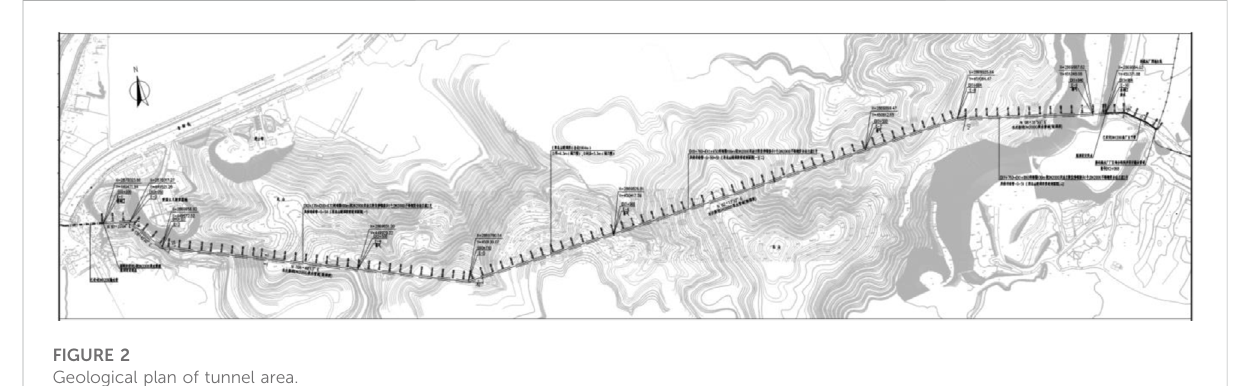
FIGURE 2 Geological plan of tunnel area.